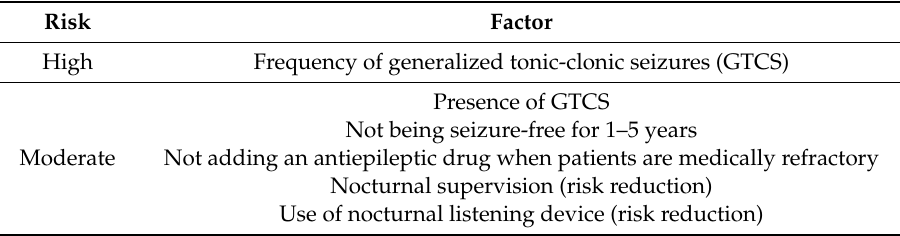
Table 2. SUDEP risk